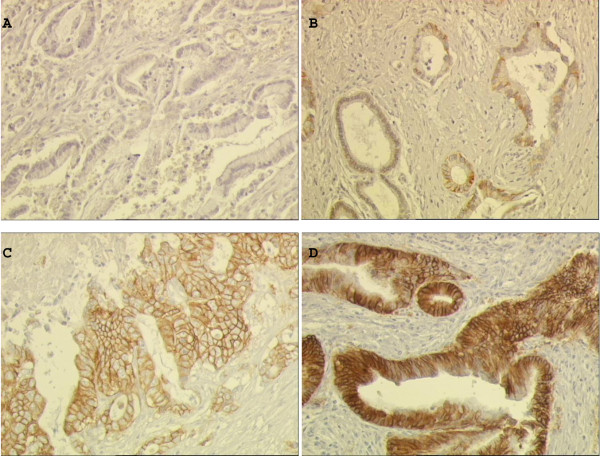
Pattern of ErbB2 expression by HercepTest in the biliary tumors. Scoring from 0 to 3+ (A, B, negative; C 2+ and D 3+). Magnification X200.